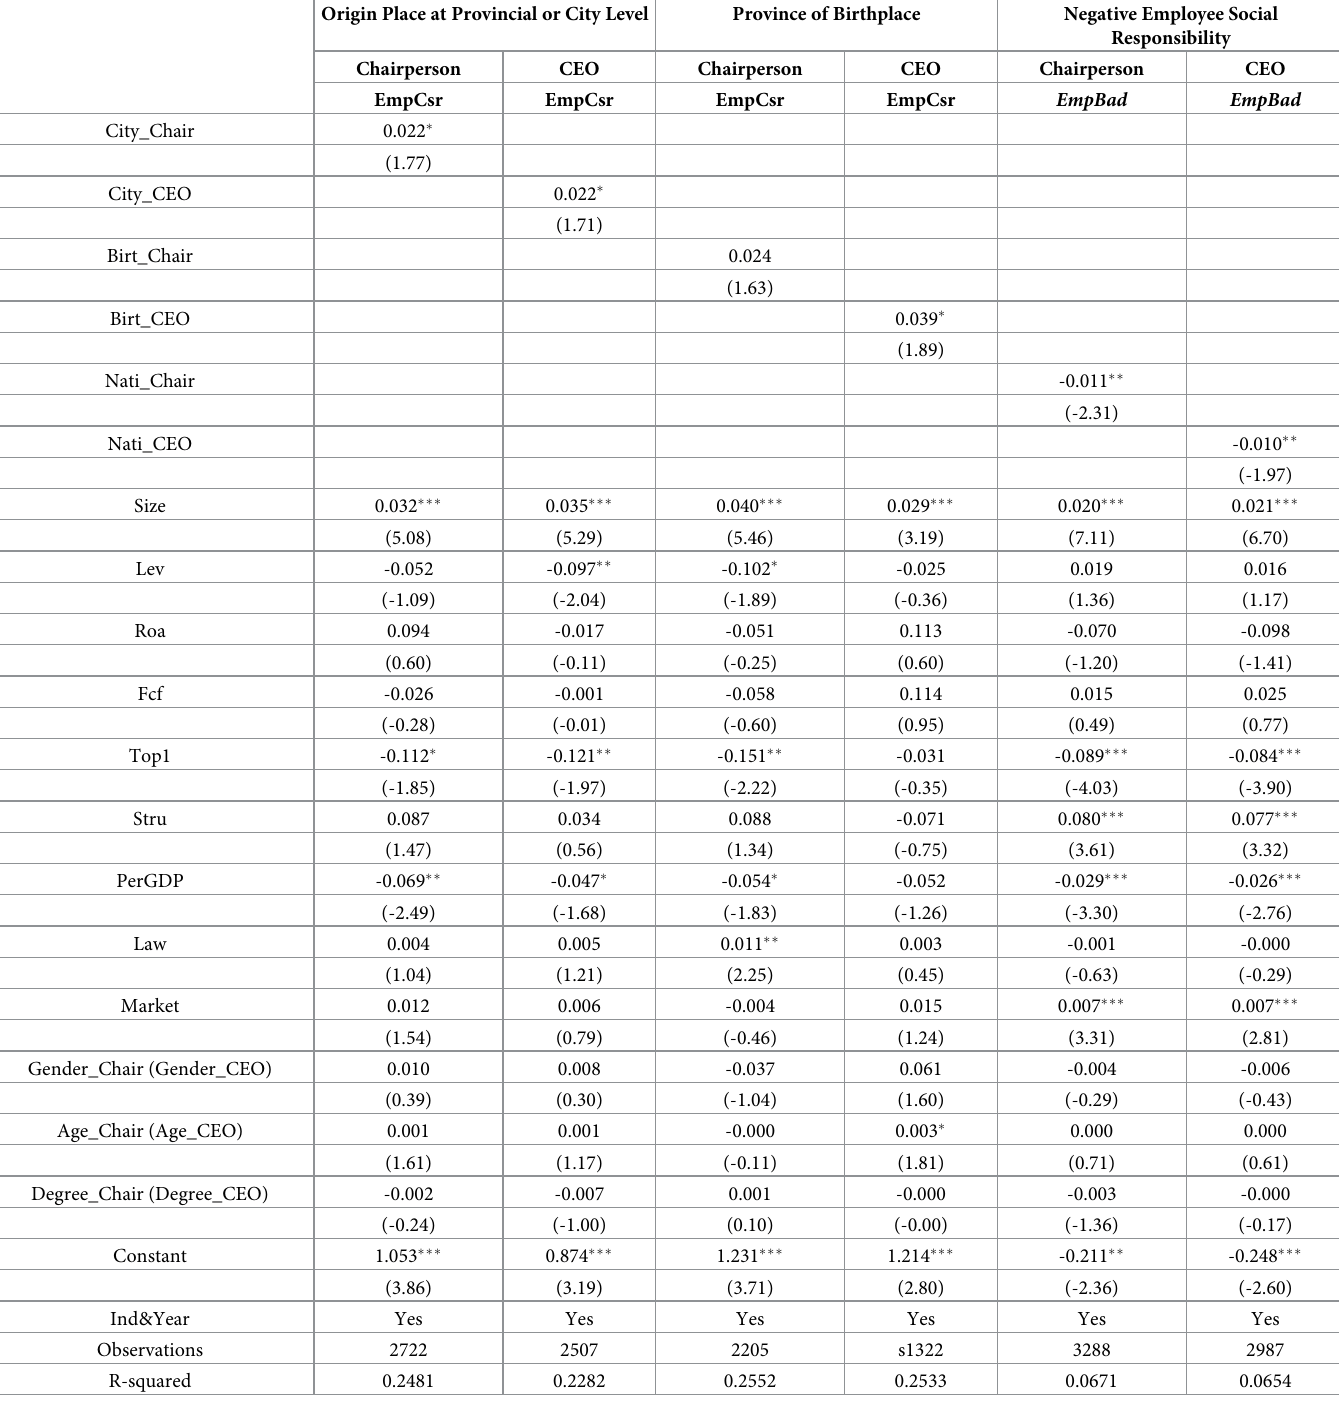
Table 7. Robustness test: Sensitivity